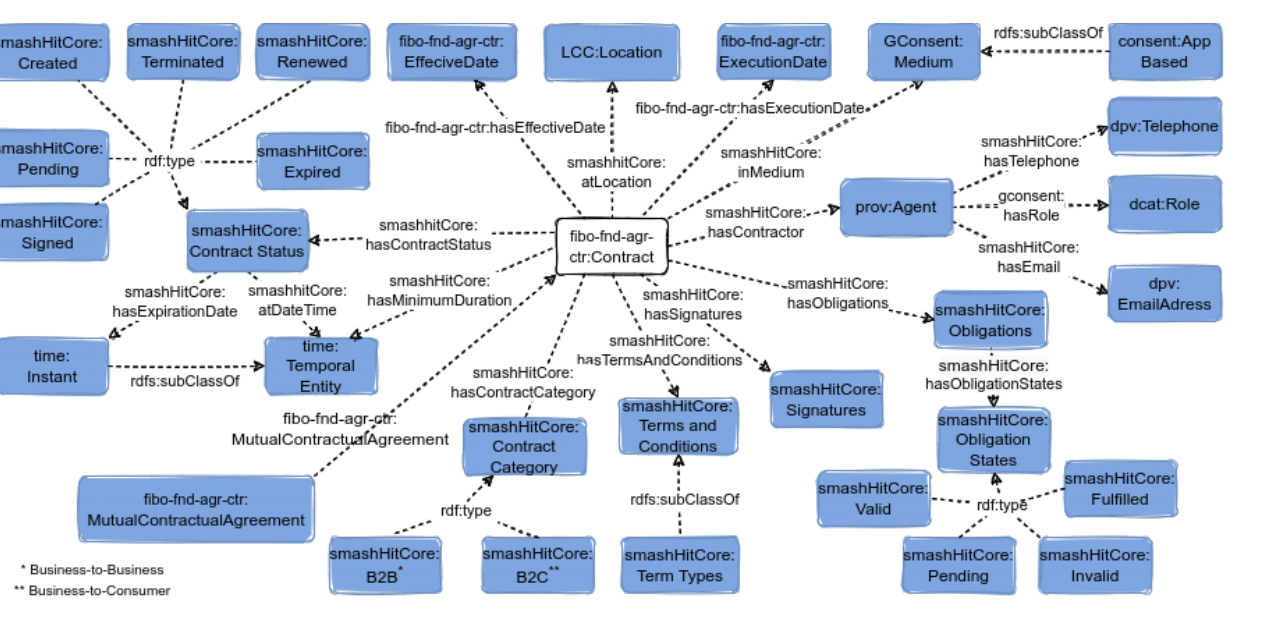
Figure 2. Semantic representation of contracts in